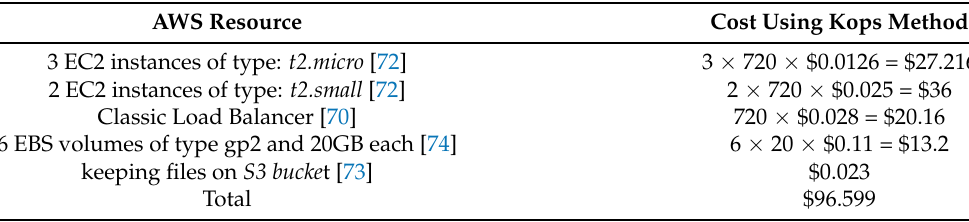
Table 4. Expected cost of running a Kubernetes cluster created with kops for one